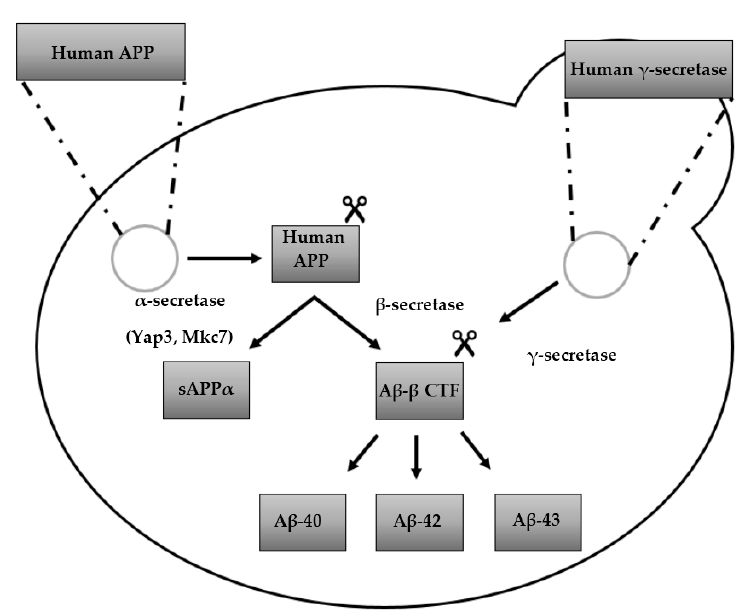
Figure 2. Humanized yeast model expressing human proteins, APP and γ -secretase: overview of Secretase-mediated APP processing and A β peptide production. The scissors icon indicates cleavage of the respective proteins.